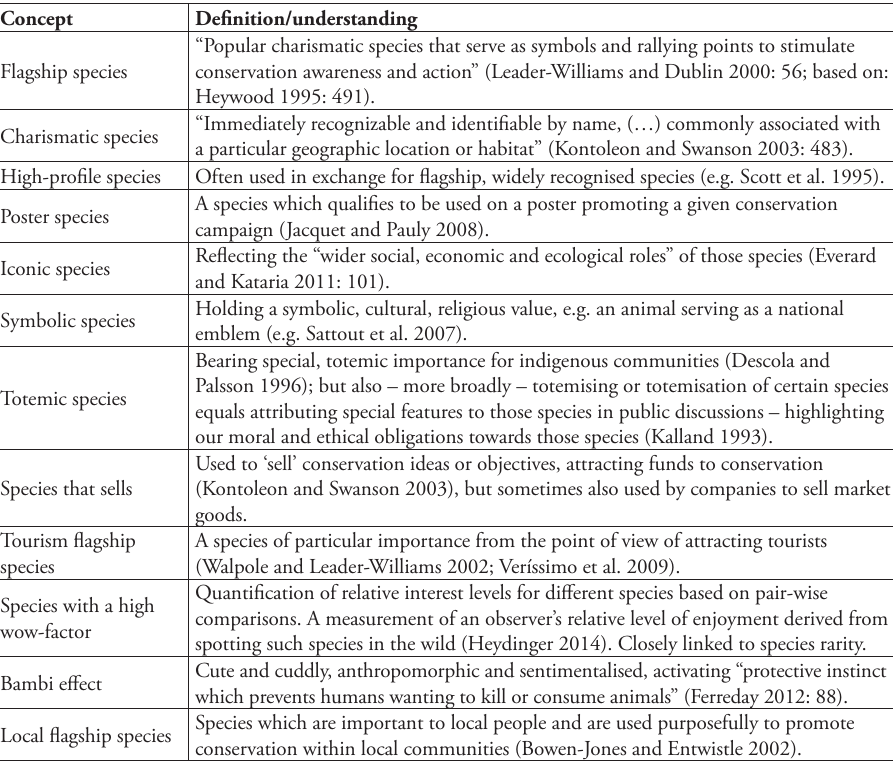
Table 2. Concepts focusing on the special social importance of a